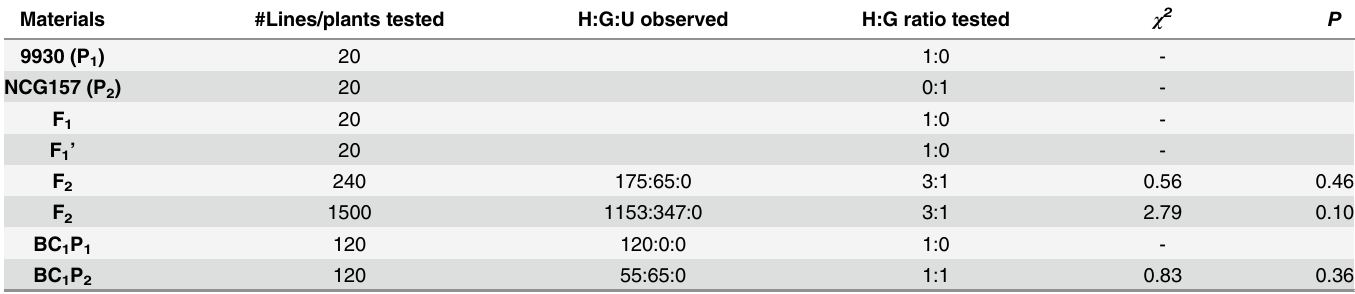
Table 1. Segregation of hairy and glabrous plants among different populations derived from hairy cucumber line 9930 and glabrous cucumber NCG157.